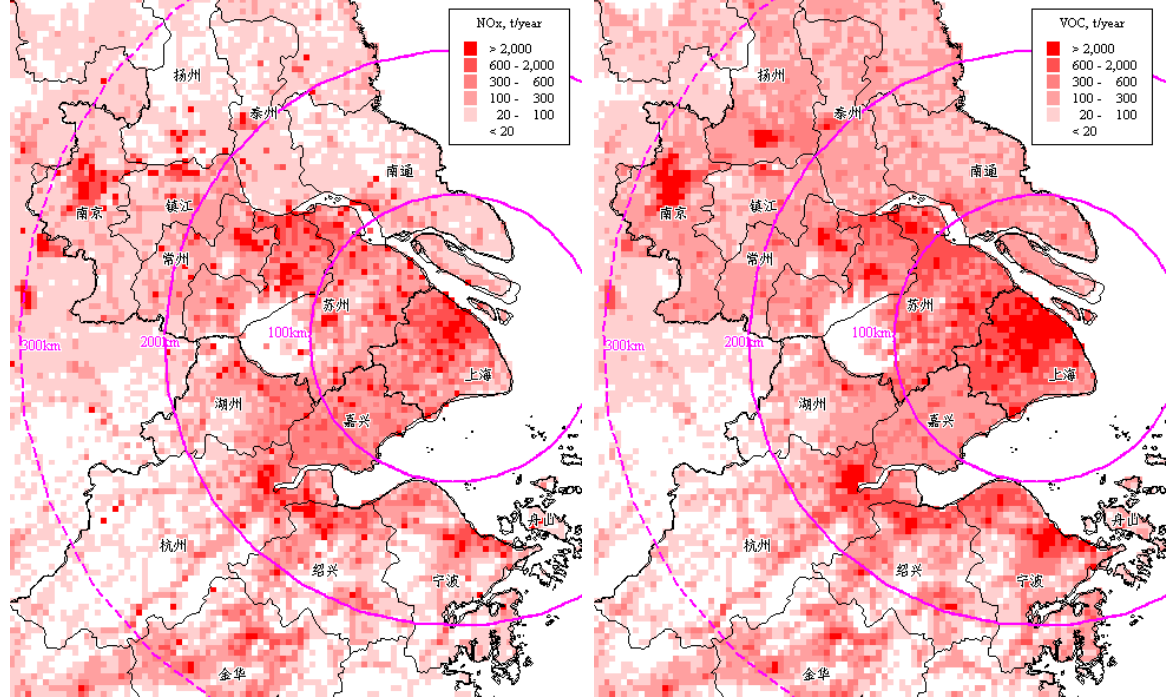
Fig.2. Emission distribution of NO